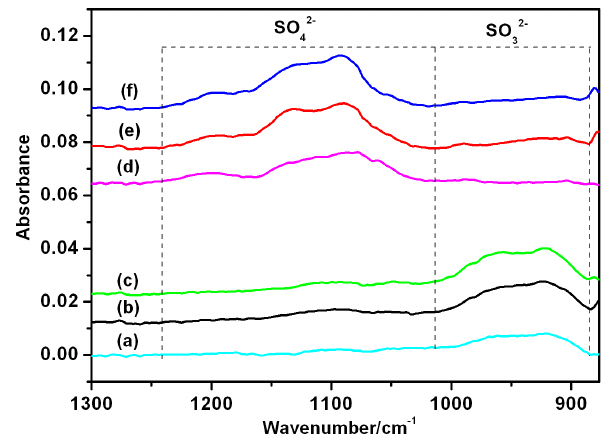
Fig. 1. In situ DRIFTS spectra (absorbance units) of surface prod- ucts when CaCO 3 particles were exposed simultaneously to SO 2 (4.9 × 10 14 moleculescm − 3 ) and O 3 (4.9 × 10 14 moleculescm − 3 ) for 200 min at different temperatures under dry conditions (RH < 1%). The spectra were ordered by increasing sulfate inten- sity.